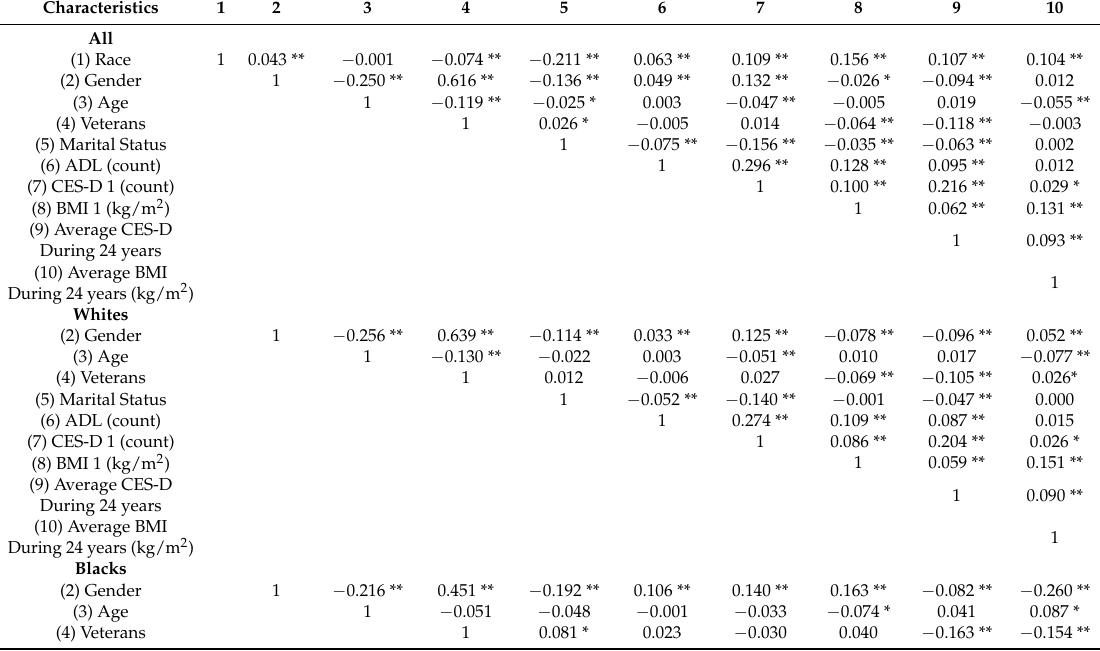
Table 2. Correlation matrix of the study variables in the pooled sample and based on